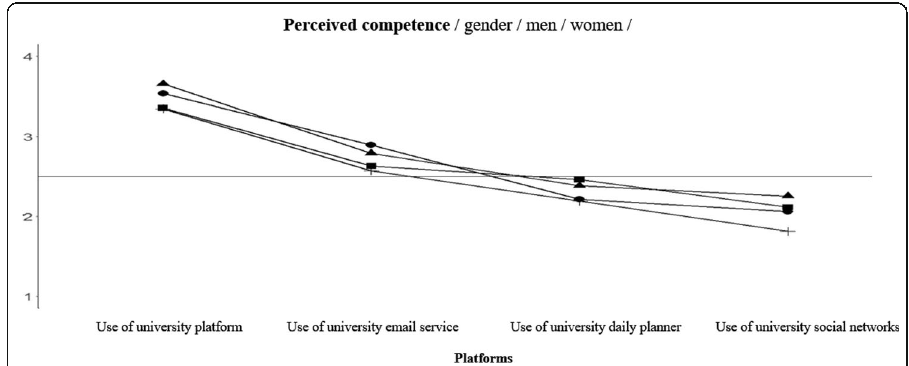
Fig. 7 Perceived competence in the use of virtual